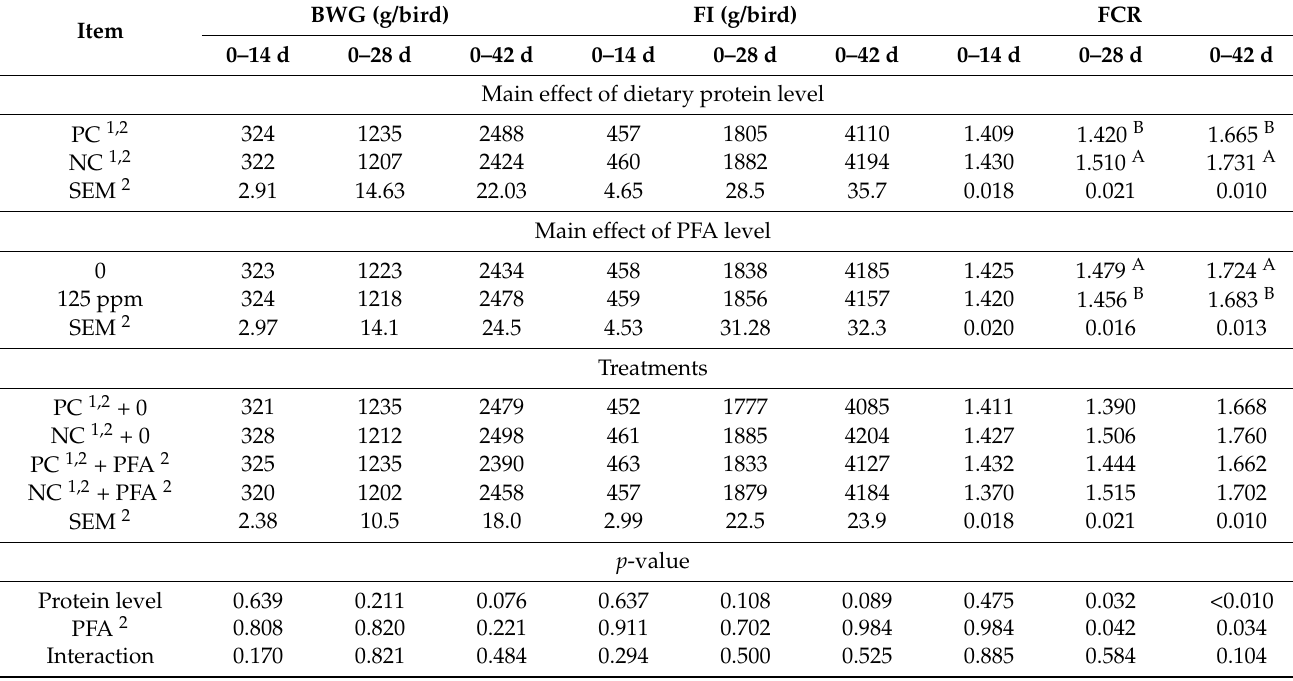
Table 3. Effects of crude protein level and phytogenic feed additive on the growth performance of